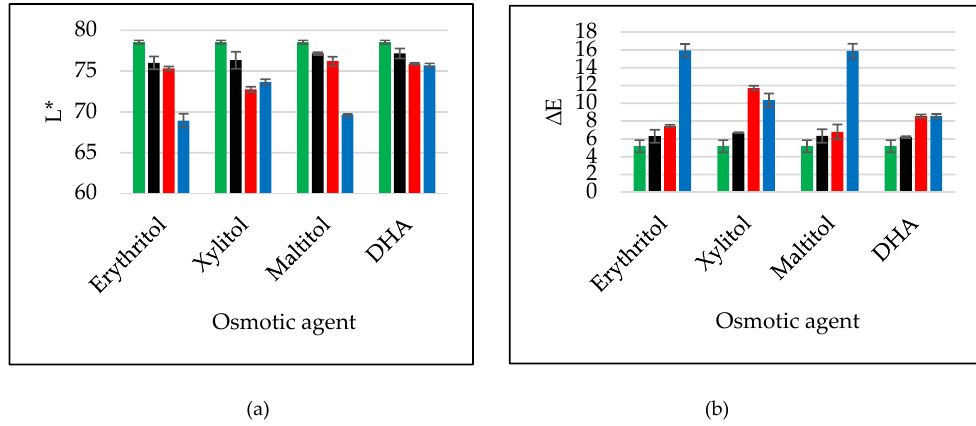
Figure 6. Colour changes after 120 min OD of apples: values of parameter L* ( a ), values of absolute colour difference ( b ) in several conditions (OD (black bars), OD+US (red bars), OD+USi (blue bars)) at 40 °C using different solutions. The green bars are values for reference (sucrose).